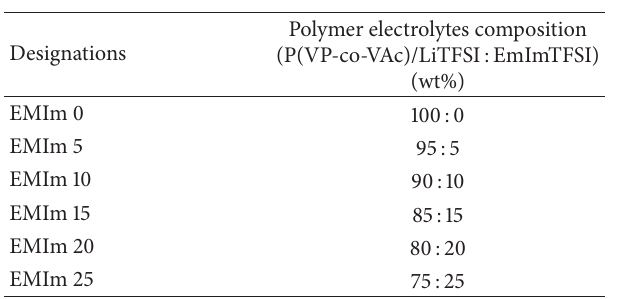
Table 1: Designation of the developed polymer electrolytes with its respective materials composition ratio.